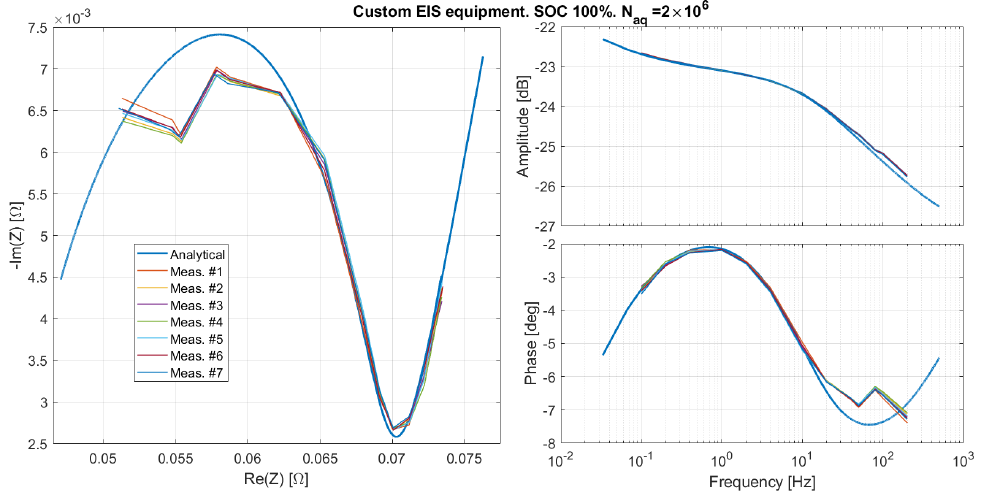
Figure 10. The emulated impedance as measured by the custom EIS system for seven repeated